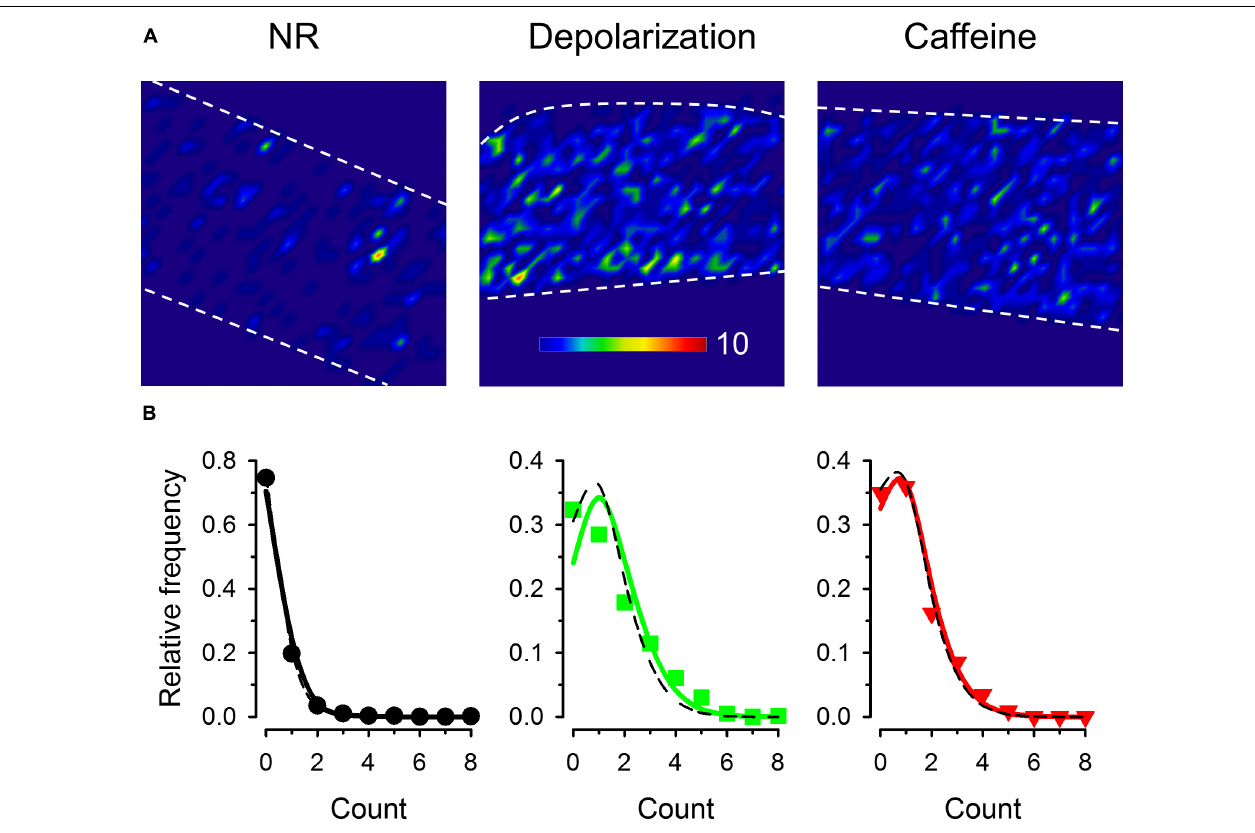
FIGURE 5 | Identifying positions of spark occurrence in images. (A) Mesh plot of frequencies of spark occurrence (i.e., the number of sparks in the given region) in a 16 × 16 pixel voxels (generated from 60 consecutive images). All images were recorded with 30 FPS. (B) Frequency distribution of regions with different number of sparks. Solid line superimposed is the fitted Poisson distribution, while dashed black curves show the Poisson distribution generated with λ being equal to the average event numbers. The values for λ used to generate the dashed curves were 0.349, 1.42, and 1.12 while those obtained from the fits were 0.281, 1.19, and 1.04 for control conditions, for depolarized fibers, and in the presence of caffeine,